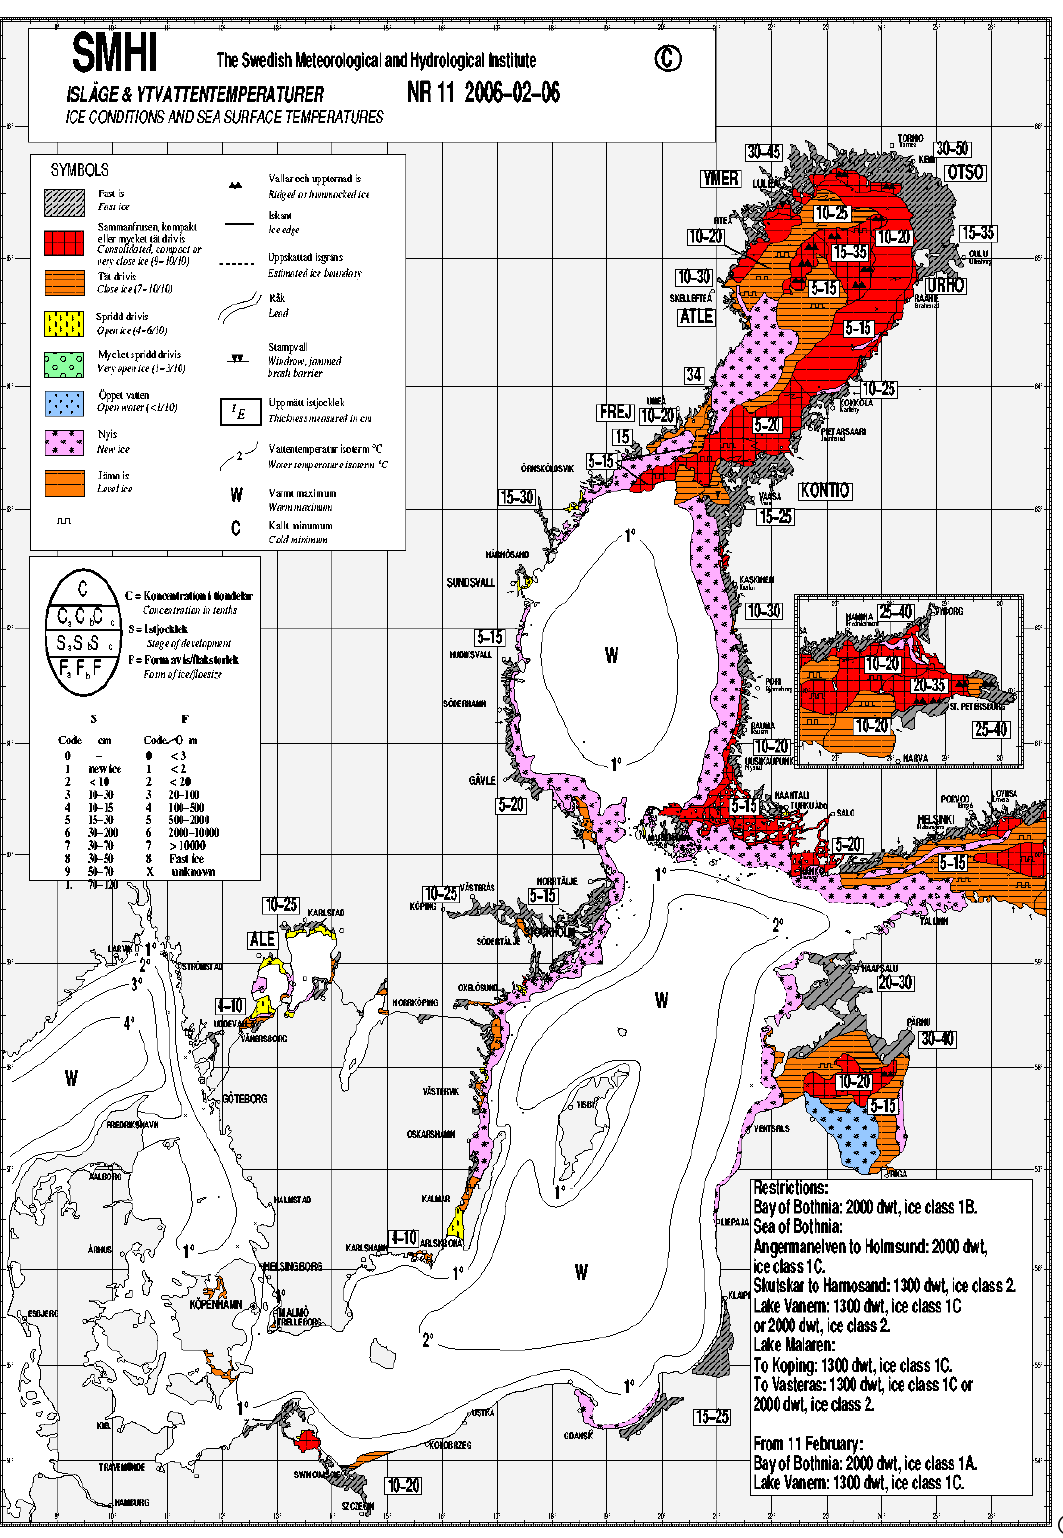
Fig. 5. Sea ice in the Baltic Sea on 6 February 2006: SMHI ice chart (a) , SIDADS ice concentration (b) , modelled ice concentration and velocity (c) , modelled ice thickness ( d ; in cm). In (c) , maximum ice velocity is 0.39ms − 1 .